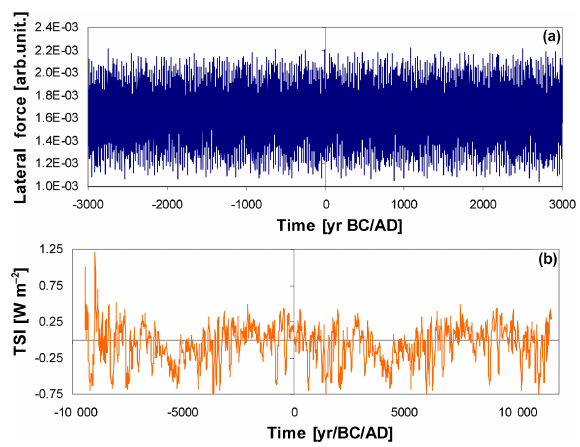
Figure B2. (a) Double integral of the solar lateral inertial forces σF 2 ( t ) due to the solar movement resulting from the planetary grav- itational forces shown in Fig. 1a, and (b) double integral of the so- lar reconstructed and extrapolated record σT 2 ( t ) shown in Fig. 1b. Vertical scale of values were inverted both in σF 2 ( t ) and σT 2 ( t ) because the double integral procedure changes the sign of the en- hanced result. Please note that the last minimum of lateral inertial force F was around 2500BC and the next minimum of TSI will be expected around AD4200. Please note the time difference between these minima of around 6700